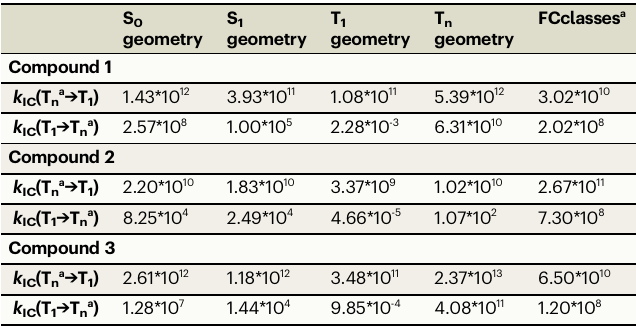
Table 4 | Internal conversion rates ( k IC , s − 1 ) between T 1 and T n of 1 – 3 calculated by different methods ( n = 2 for compound 1 and 2, n = 3 for compound 3). Geometries and frequencies are calculated at TD- ω B97XD/6-31G(d,p) level of theory, and energy differences are calculated at TD- ω B97X-D3/def2-